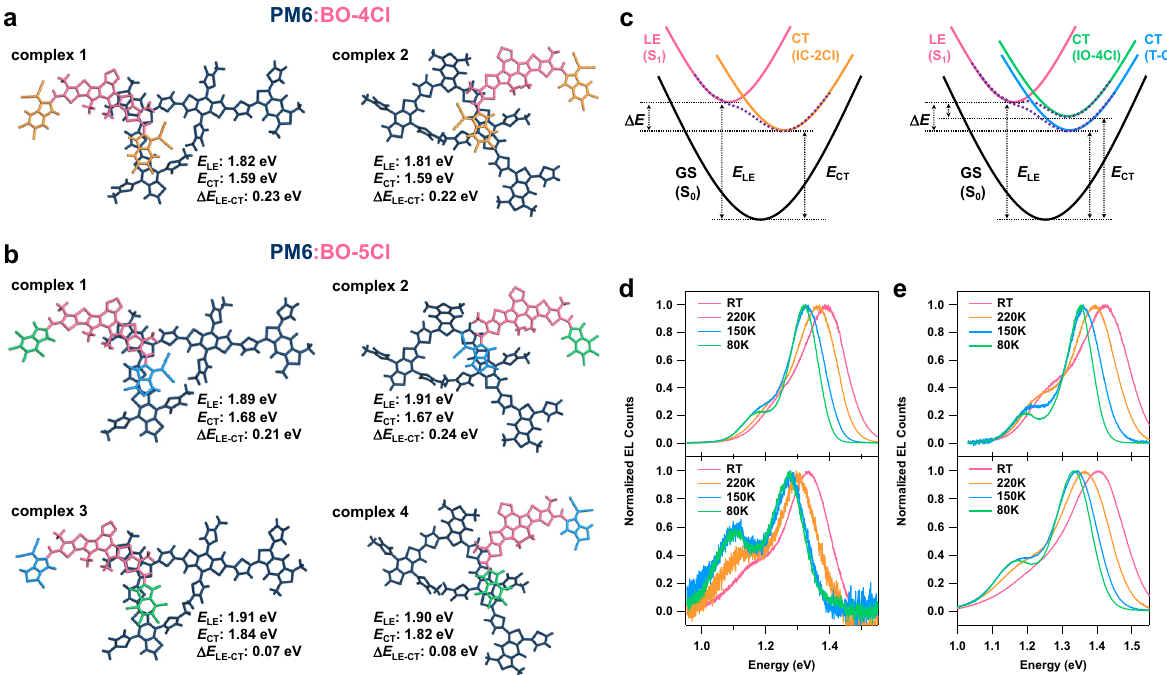
Fig. 4 D:A complex con fi gurations, calculated state energies, and temperature-dependent EL spectra. a PM6:BO-4Cl and b PM6:BO-5Cl complexes as well as the relevant energies of the LE and CT states and their differences. c Diagrams of the energy differences. d Temperature-dependent EL spectra of BO-4Cl (upper part) and PM6:BO4Cl (lower part) fi lms. e Temperature-dependent EL spectra of BO-5Cl (upper part), and PM6:BO-5Cl (lower part) fi